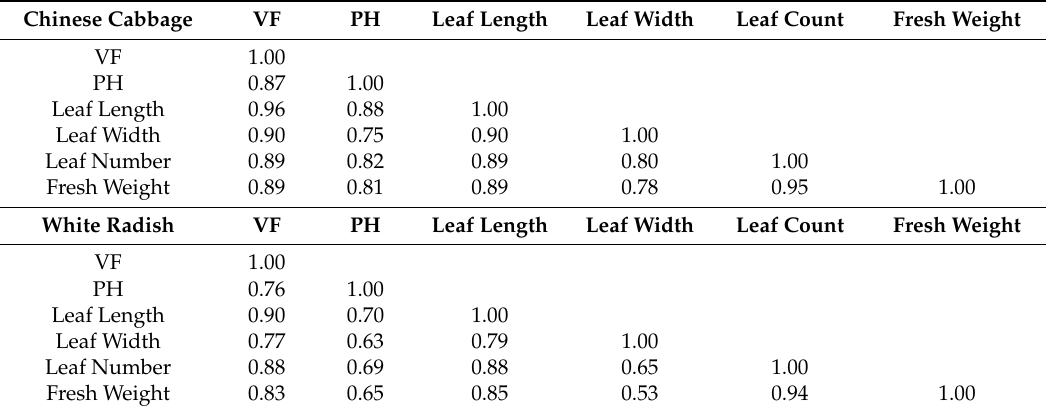
Figure 11. Temporal changes in growth status of ( a , b ) Chinese cabbage and ( c , d ) white radish in terms of ( a , c ) escess green (ExG)-based vegetation fraction and ( b , d ) structure from motion (SfM)-estimated plant height. For ease of visualization, data are presented in boxplot format. Mean vegetation fractions and plant heights followed by the same letter within days after transplanting (DAT) or days after seeding (DAS) are not significantly different at the 5% level, based on the F-test. Table 6. Results of correlation analysis among biophysical parameters and vegetation fraction (VF) and plant height (PH) for Chinese cabbage (top) and white radish